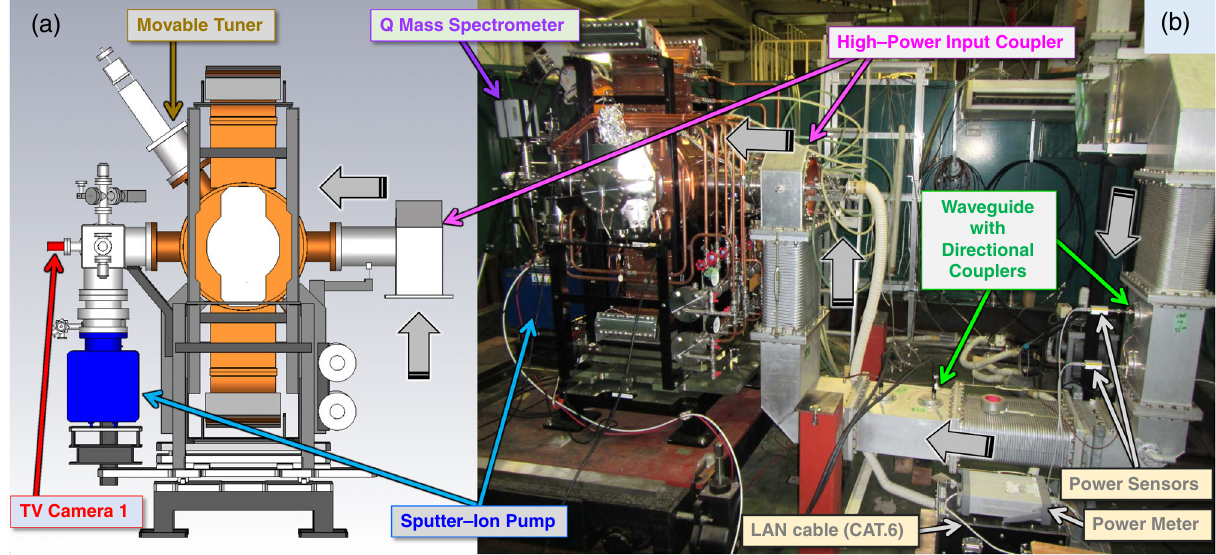
FIG. 3. (a) Diagram of DR cavity No. 2. (b) Photograph of the test stand used for the high-gradient test of DR cavity No. 2 in a radiation-controlled area. The bold arrows indicate the flow of high rf power generated by a 1.2-MW continuous-wave klystron. The klystron is not included in this photograph. The turbo-molecular pump is behind the